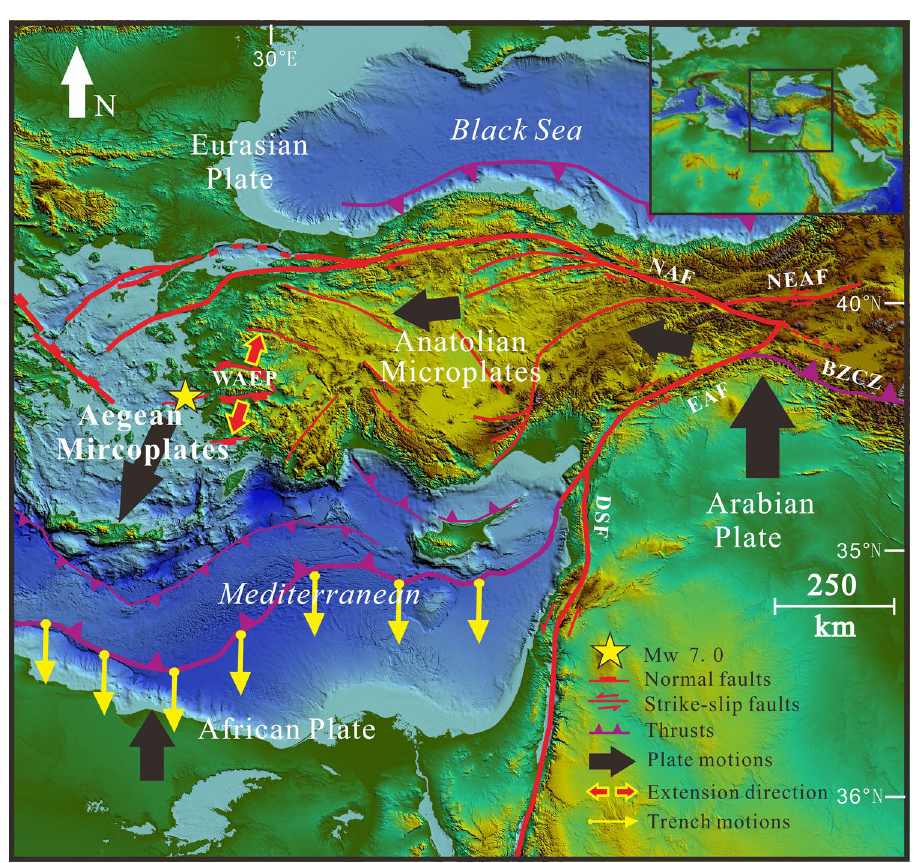
Figure 1. Tectonic background of Aegean and Anatolia 2,3 . WAEP Western Anatolian extension province; NAF North Anatolian fault; EAF East Anatolian Fault; DSF Dead Sea Fault; BZCZ Bitlis-Zagros collision zone. Dashed white line outlining rectangle represents the area of Fig. 2b. Bold black arrows indicate direction of motion of plates, yellow arrows attached to trench indicate direction of trench and slab rollback. Red arrows in western Anatolia indicate direction of extension of upper plate, and yellow star is location of the Mw 7.0 Samos earthquake of October 30,